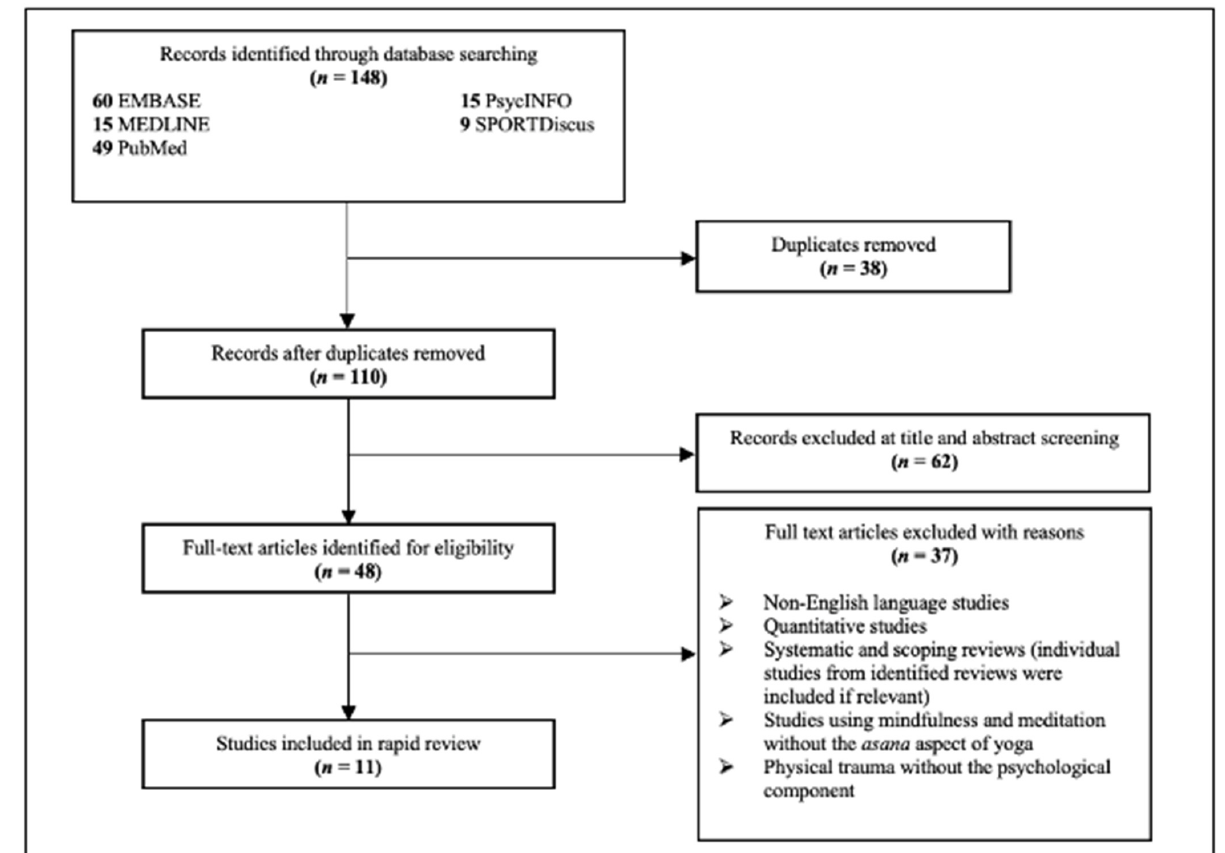
Figure 1. Results of the systematic electronic search.